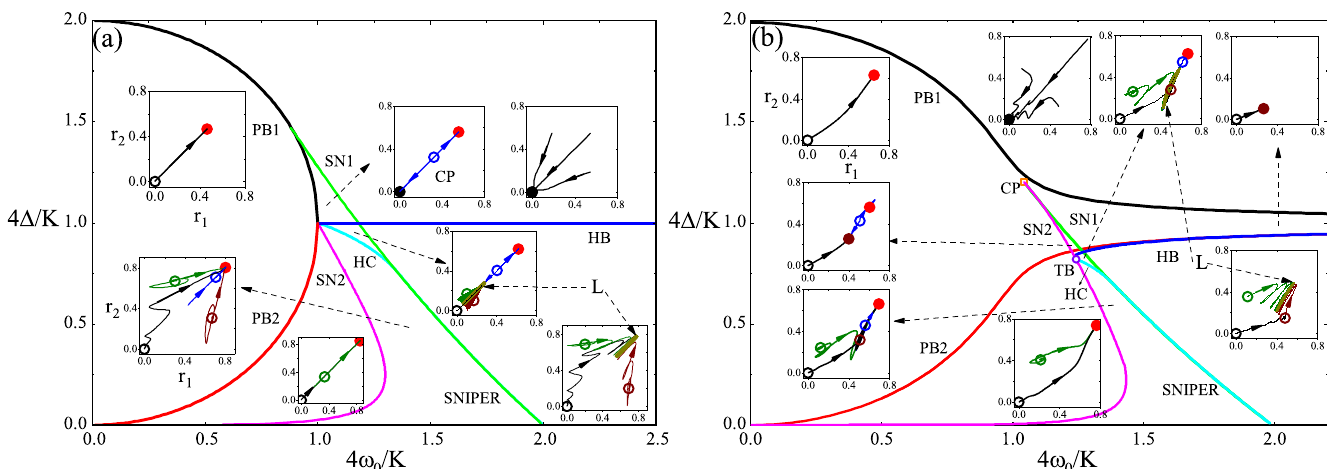
Fig 3. (Color online) Bifurcation diagrams on the ( Δ 0 = 4 Δ / K , ω 0 = 4 ω 0 / K ) plane for (a) β = 0 and (b) β = 0.1. Line color codes: black and red for two pitchfork bifurcations, PB1 and PB2, respectively; green and pink for two saddle-node bifurcations, SN1 and SN2, respectively; blue for HB (Hopf bifurcation); cyan for HC (homoclinic bifurcation). Acronyms: SNIPER for saddle node infinite period; CP for cusp point of SN1 and SN2; TB for Takens-Bogdanov point. To present the topological structure of the phase space in different phase domains, we plot the phase portraits on the ( r 1 , r 2 ) plane in several insets with the parameters chosen from different phase domains. The dashed arrows pointing to insets refer to the phase domain represented by the insets. In each inset, several phase portraits (wiggly lines) are plotted with arrows representing the evolution from or towards the solutions in Eq (12). In these insets, solid (open) dots represent stable (unstable) partial synchronous states, while the dark yellow curves represent stable standing wave partial synchronous state denoted by L . The solutions in the same color in different insets are the same solution. K = 4.